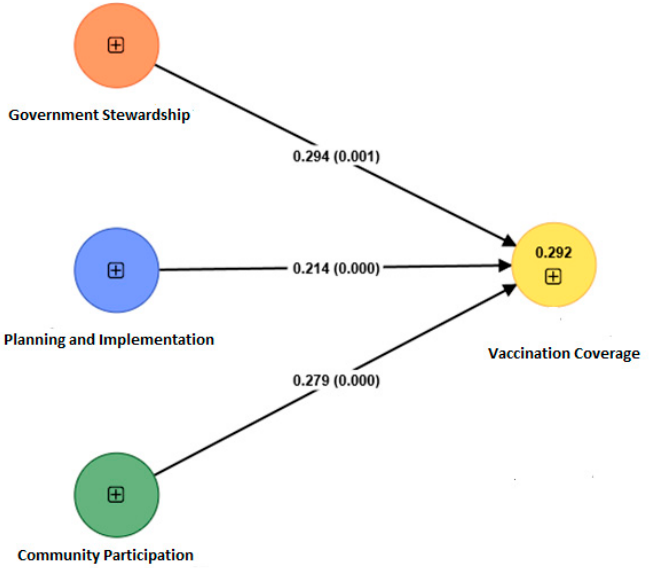
Figure 2. Empirical validation of the model . Table 7. Hypothesis testing .